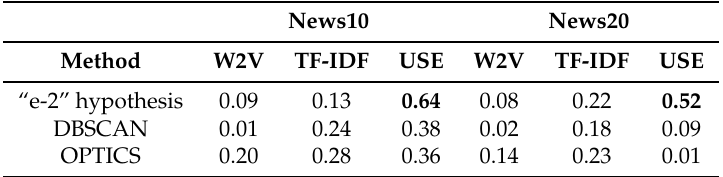
Table 4. V-measure for News10 and News20.